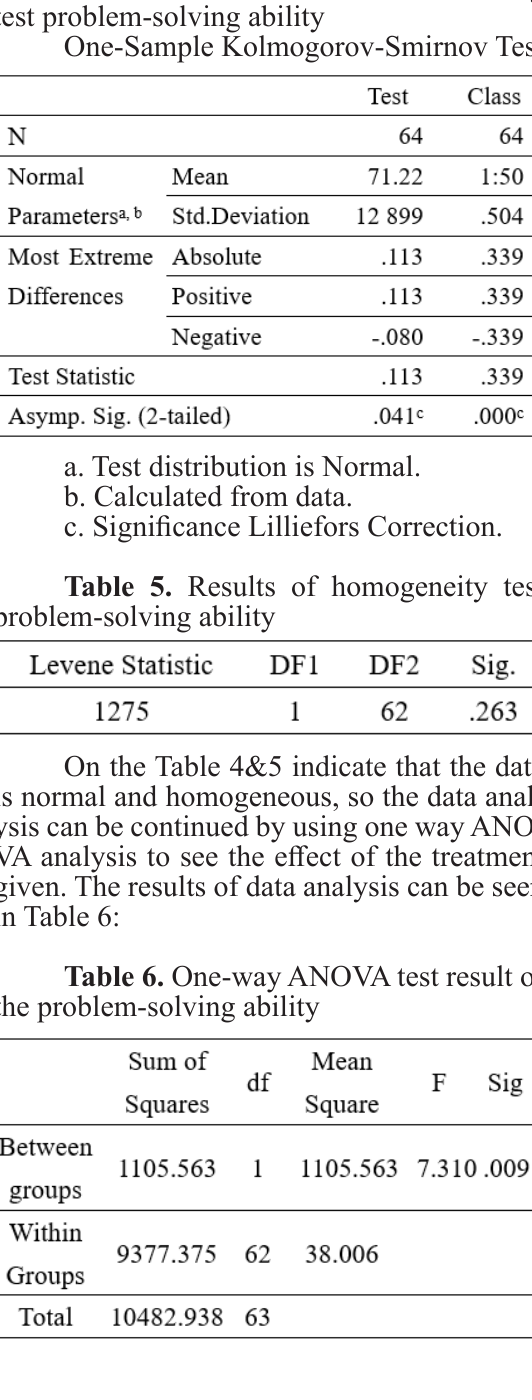
Table 4. Results of the test of normality